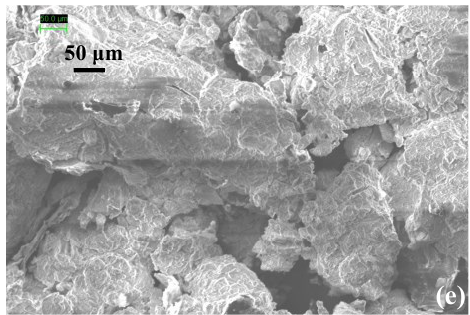
Figure 2. SEM images of hybrid/composite materials, obtained after convenient drying in an oven under constant rather low temperature (~40 °C); ( a ) GO; ( b ) PFSiC 1.5-15 ; ( c ) GO-PFSiC 1.5-15-1 ; ( d ) GO- PFSiC 1.5-15-0.5 ; and ( e ) GO-PFSiC 1.5-15-0.3 .